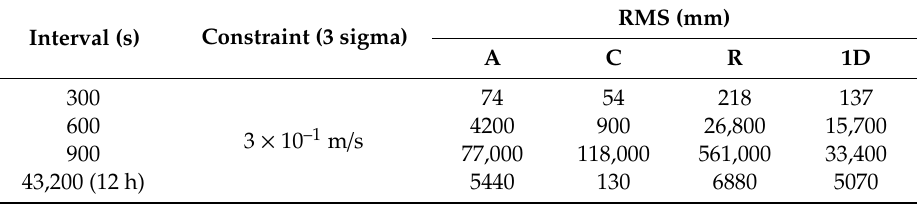
Table 4. Di ff erences of orbits estimated and published by CODE